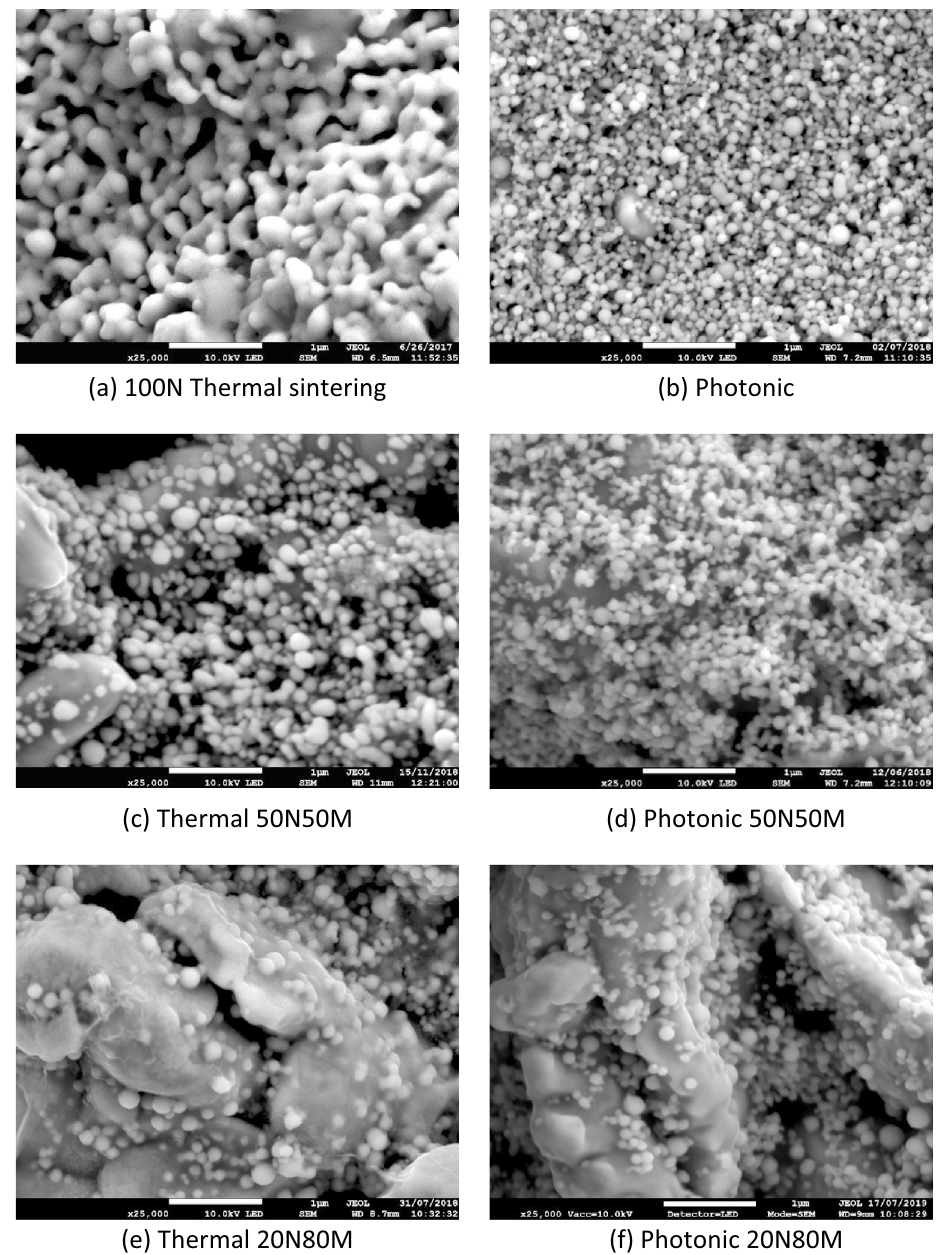
Figure 9. SEM images at × 25,000 for each material at its optimum thermal and photonic sintering condition. Thermal sintering in ( a ), ( c ) and ( e ) corresponds to 200 °C, 90 min in Formic acid reducing atmosphere. Photonic ( b ), ( d ) and ( f ) correspond to the optimum conditions (lowest resistance) obtained